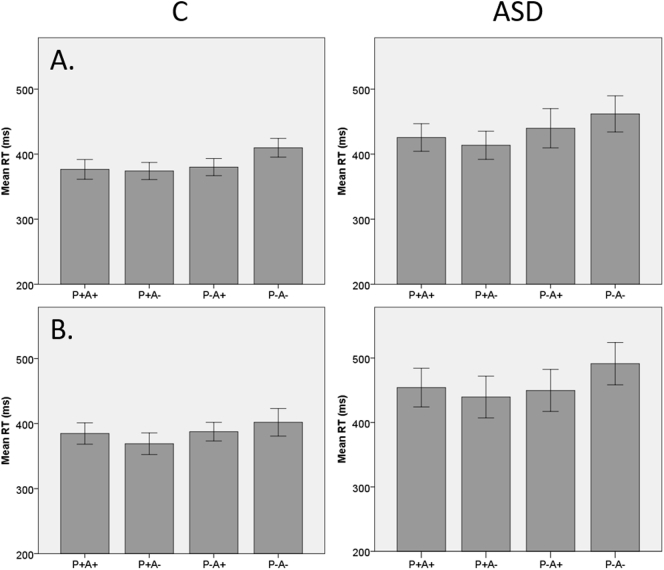
Average reaction times to the ball per condition, in milliseconds. Error bars represent ±1 standard error. Left: control group (C); right: ASD group. A. Spontaneous task version; B. Explicit task version.